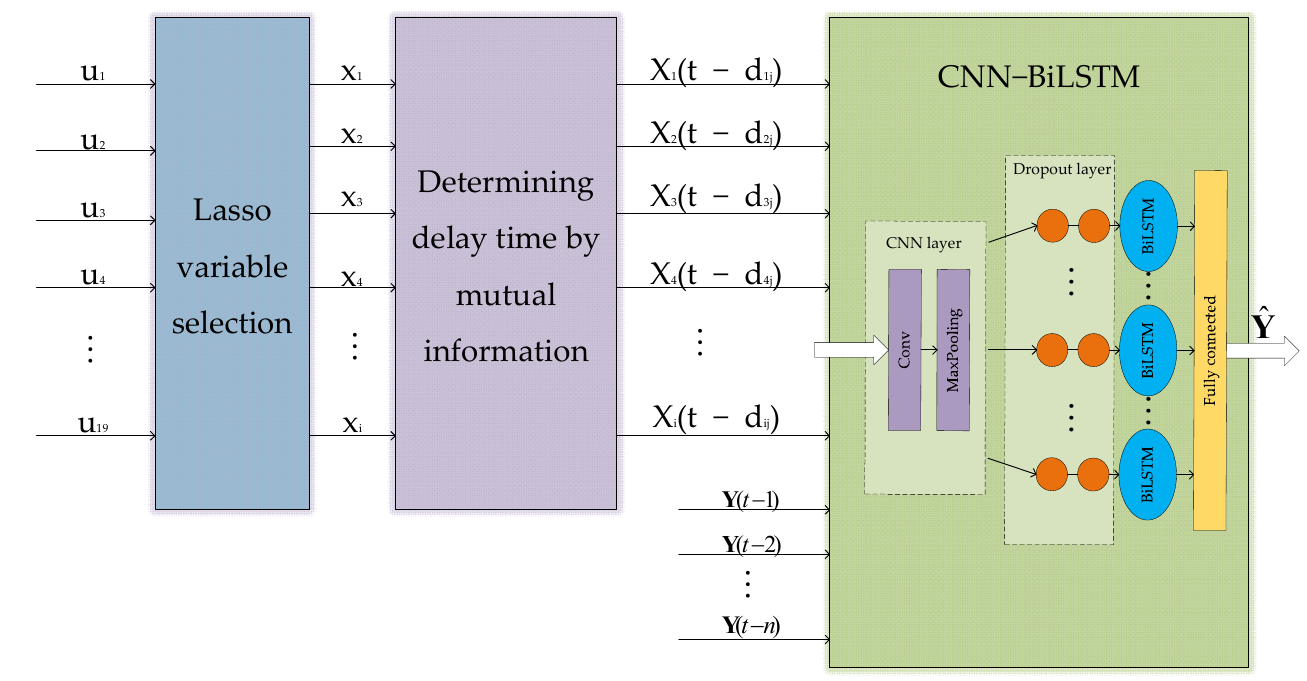
Figure 6. Modeling process